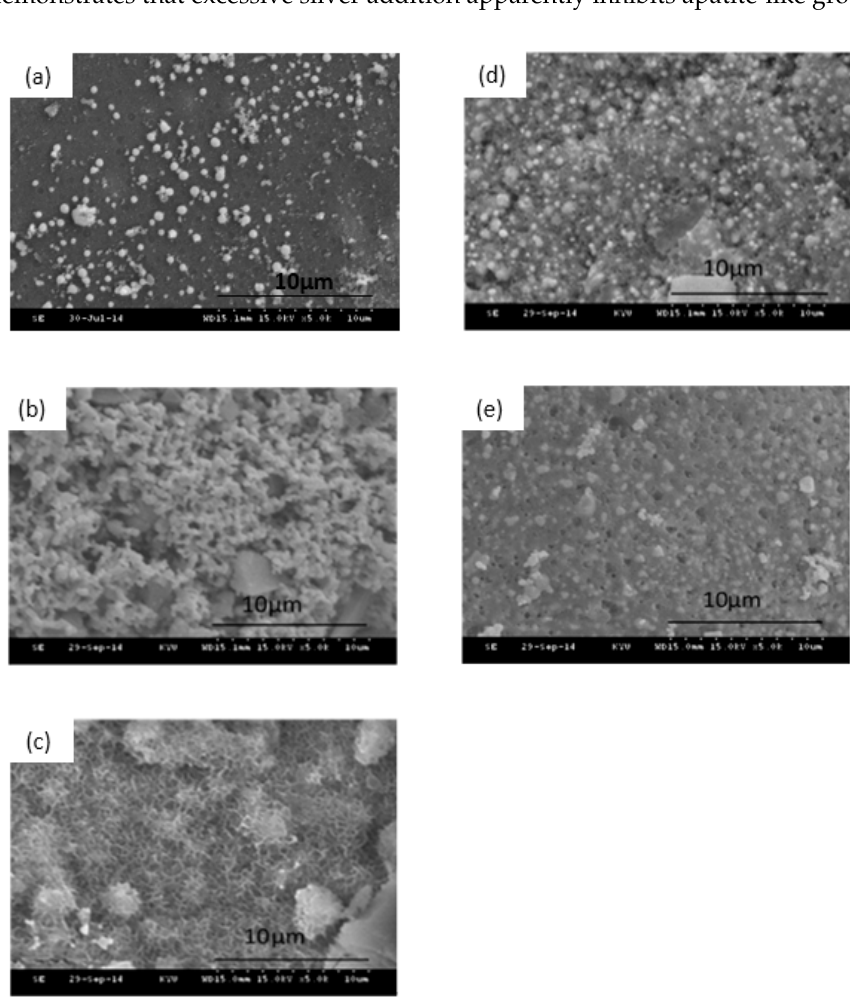
Figure 3. SEM images of Ag10/80S after immersion in PBS for different times: ( a ) 0 h; ( b ) 24 h; ( c ) 48 h; ( d ) 72 h; and ( e ) 168 h.